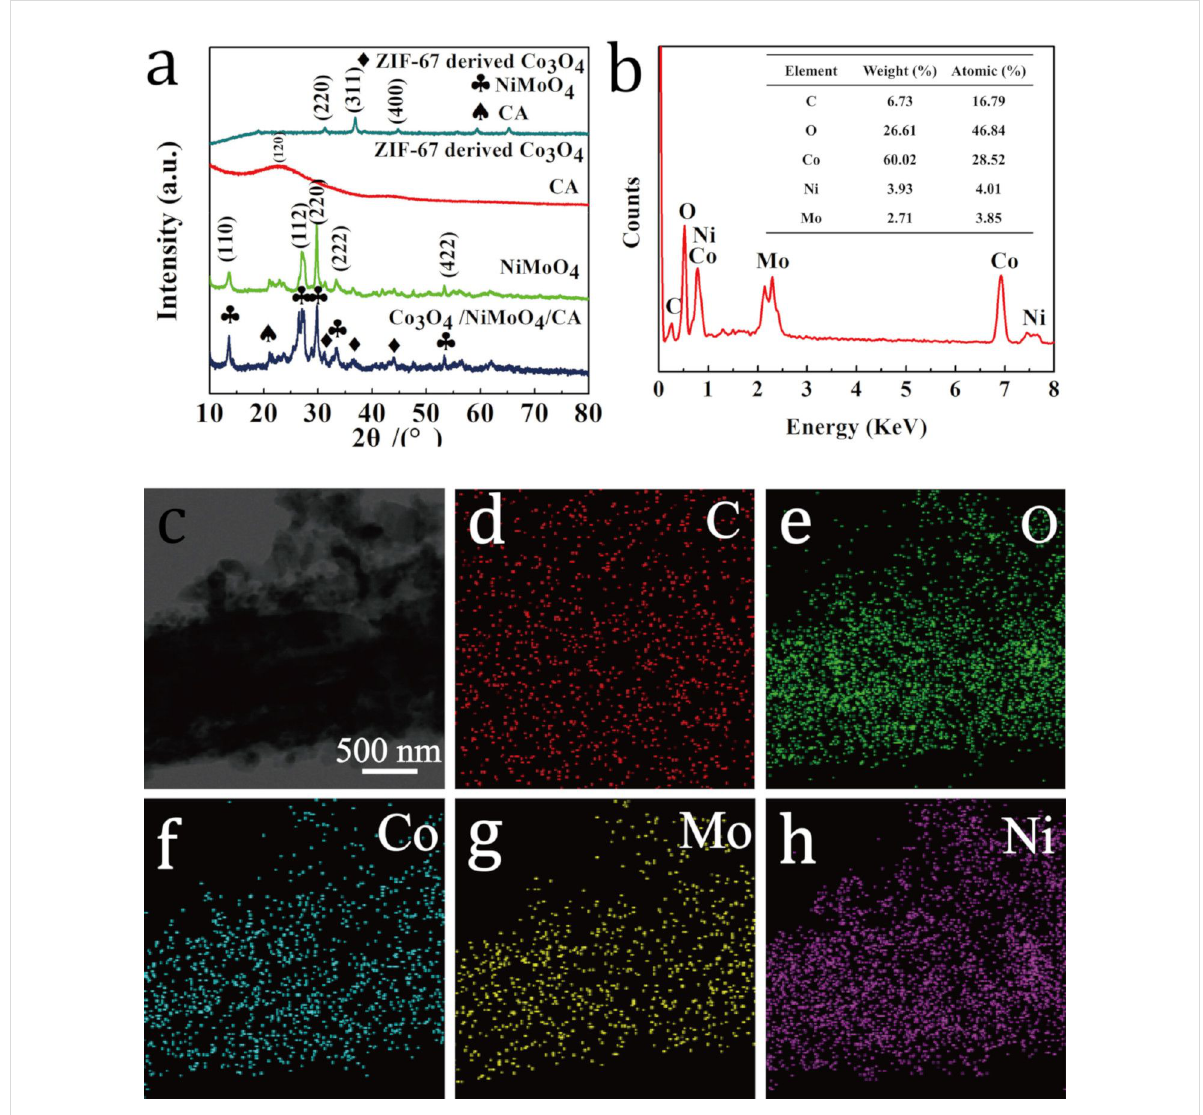
Figure 3: (a) XRD patterns of Co 3 O 4 , CA, NiMoO 4 and NiMoO 4 @Co 3 O 4 /CA (from top to bottom); (b) EDS spectrum; (c) TEM image; (d–h) elemental mapping of the NiMoO 4 @Co 3 O 4 /CA